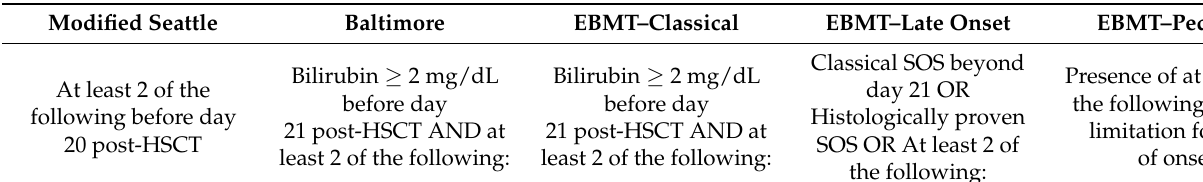
Table 1. Criteria established for diagnosis of SOS